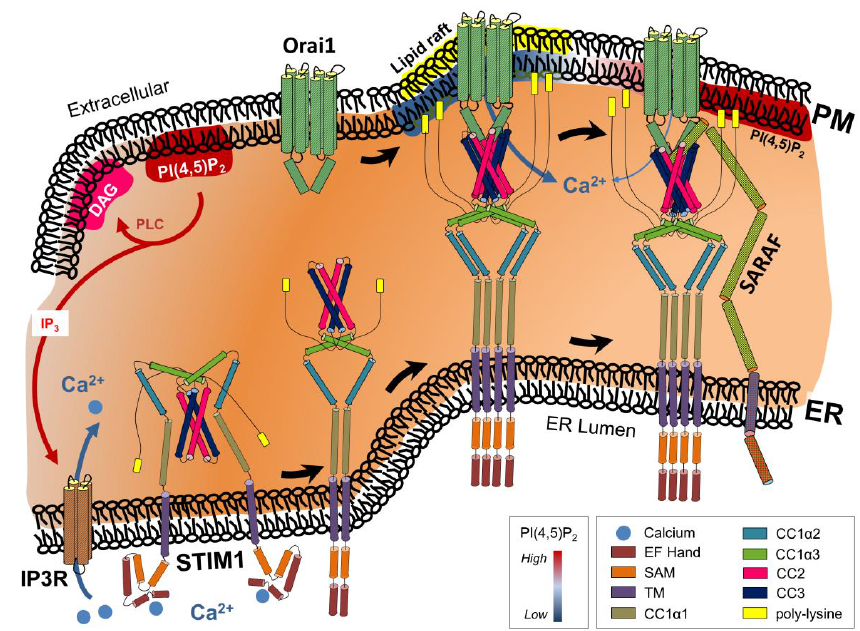
Figure 1. Receptor-induced activation of phospholipase C (PLC) generates inositol-triphosphate (IP 3 ) and diacylglycerol (DAG) from phosphatidylinositol 4,5-bisphosphate (PI(4,5)P 2 ). Binding of IP 3 to its ER membrane-localized cognate receptor releases calcium (Ca 2+ ) from ER into the cytosol. Subsequent depletion of the ER Ca 2+ store induces conformational changes in the ER Ca 2+ sensor stromal interaction molecule-1 (STIM1). Binding of STIM1 to the Ca 2+ release-activated Ca 2+ channel Orai1 within phosphatidylinositol 4,5-bisphosphate (PI(4,5)P 2 )-poor PM microdomains activates the channel, resulting in Ca 2+ from the extracellular milieu into the cytosol. Interaction of store-operated Ca 2+ entry-associated regulatory factor (SARAF) with STIM1 induces transition of the STIM1-Orai1 complex towards PI(4,5)P 2 -enriched PM microdomains, resulting in attenuation of Ca 2+ influx. See the text for more details. Although the presence of cholesterol-enriched lipid rafts is needed for proper STIM1-Orai1 functioning, the precise interaction of lipid rafts and PI(4,5)P 2 microdomains as depicted still needs to be clarified. Additional abbreviations: ER, endoplasmic reticulum; PM, plasma membrane. At the luminal site, interaction of Ca 2+ with the negatively charged aspartates and glutamates induces a helix-loop-helix conformation of the EF hand. Agonist-induced ER discharge and subsequent dissociation of Ca 2+ from the STIM EF hand destabilizes this conformation, resulting in activation of STIM1 [28]. Interestingly, while the STIM1 TM domains are not in close proximity in resting conditions, the presence of three TM domain- localized glycine residues (G223, G225, and G226) aid in the movement of the STIM1 TM domains towards each other upon Ca 2+ release from the luminal EF hand [29–31]. Subsequent homomerization of STIM1 is mediated by CC2, CC3, and SHD, which is essential for coupling to and activation of Orai1 [32,33]. X-ray crystallographic structural data of the STIM1 cytosolic region revealed a dimeric assembly with an antiparallel arrangement of CC2 and CC3 and two inter-adjacent short α-helices [34]. From these crystal structures, it could be derived that the physiological V-shaped conformation of the critical STIM-Orai1-activating region (SOAR) [26] (also referred to as channel-activating domain (CAD) [35], Orai-activating small fragment (OASF) [33,36], or coiled-coil domain- containing region b9 (CCb9) [37]) dimer is established through coiled-coil interactions of one monomer (residues R429, W430, I433, and L436) and the other (residues T354, L351, W350, and L347). Of note, mutation-induced disruption of this SOAR binding interface